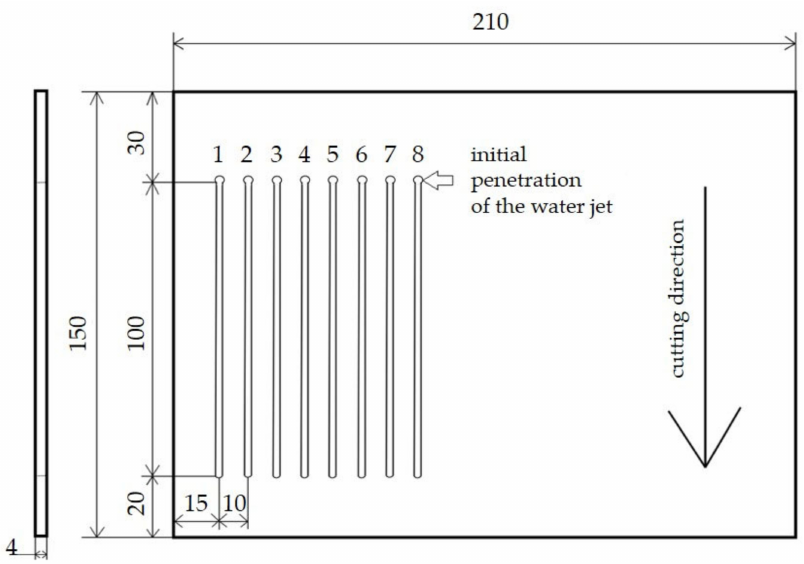
Figure 3. Layout of the waterjet cuts on the test